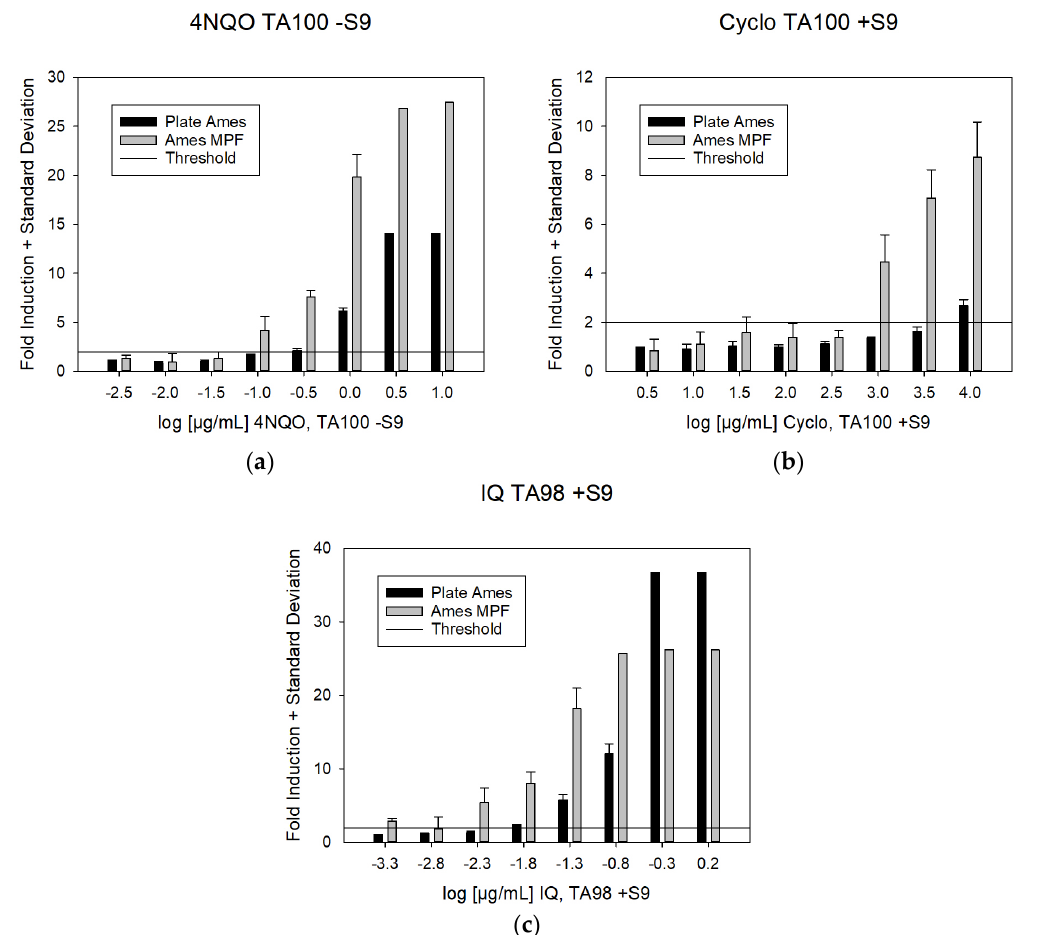
Figure 3. Fold induction of the dose-response testing illustrating differences of dose-responses across test protocols. The bar charts show example results for the dose response curves, obtained with the Ames MPF TM and the standard pre-incubation Petri-dish agar-based Ames assay. The line across the chart indicates the positive threshold, which refers to a two-fold induction over the mean negative control results, including one standard deviation. ( a ) 4NQO tested with TA100, without metabolic activation, ( b ) Cyclo tested with TA100 with metabolic activation and ( c ) IQ tested in TA98 with metabolic